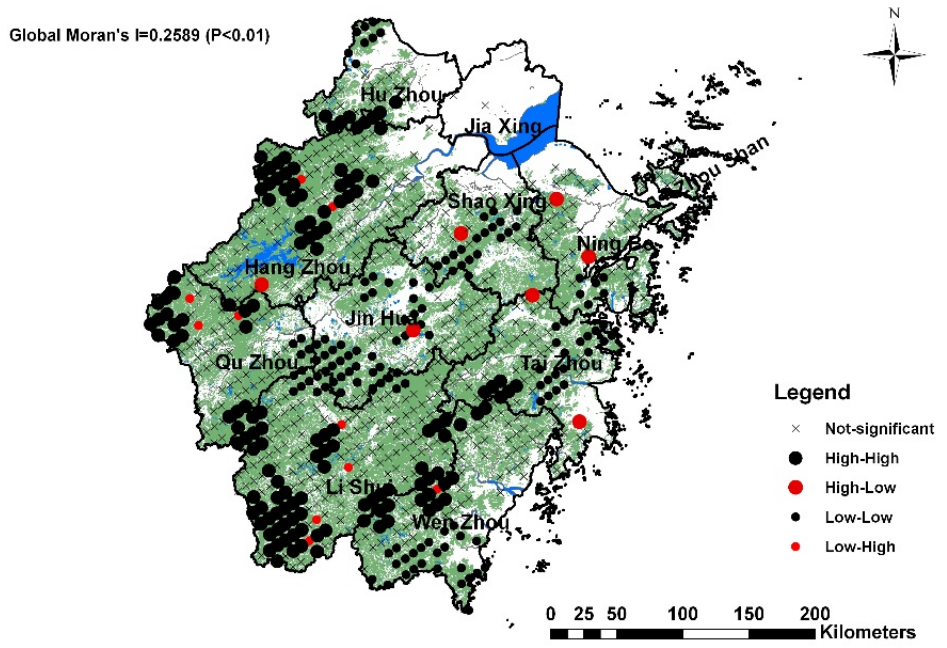
Figure 6. Spatial clusters and spatial outliers map of FBC